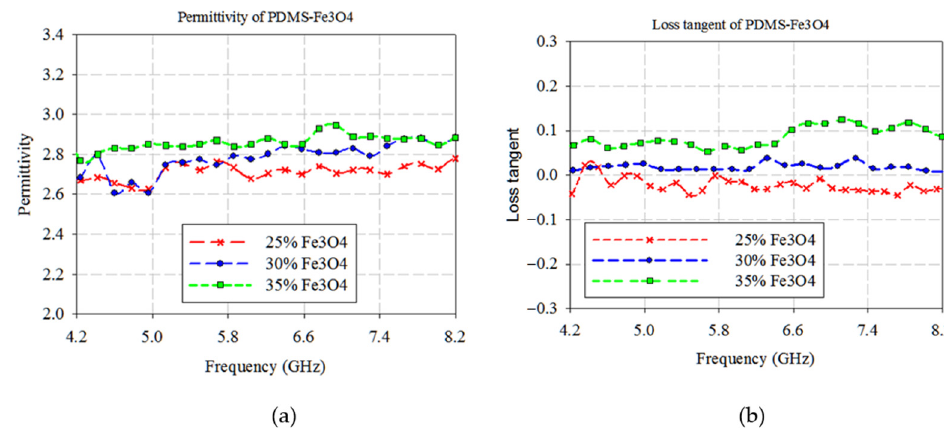
Figure 4. PDMS − Ferrite measurement results for permittivity ( a ) and loss tangent ( b